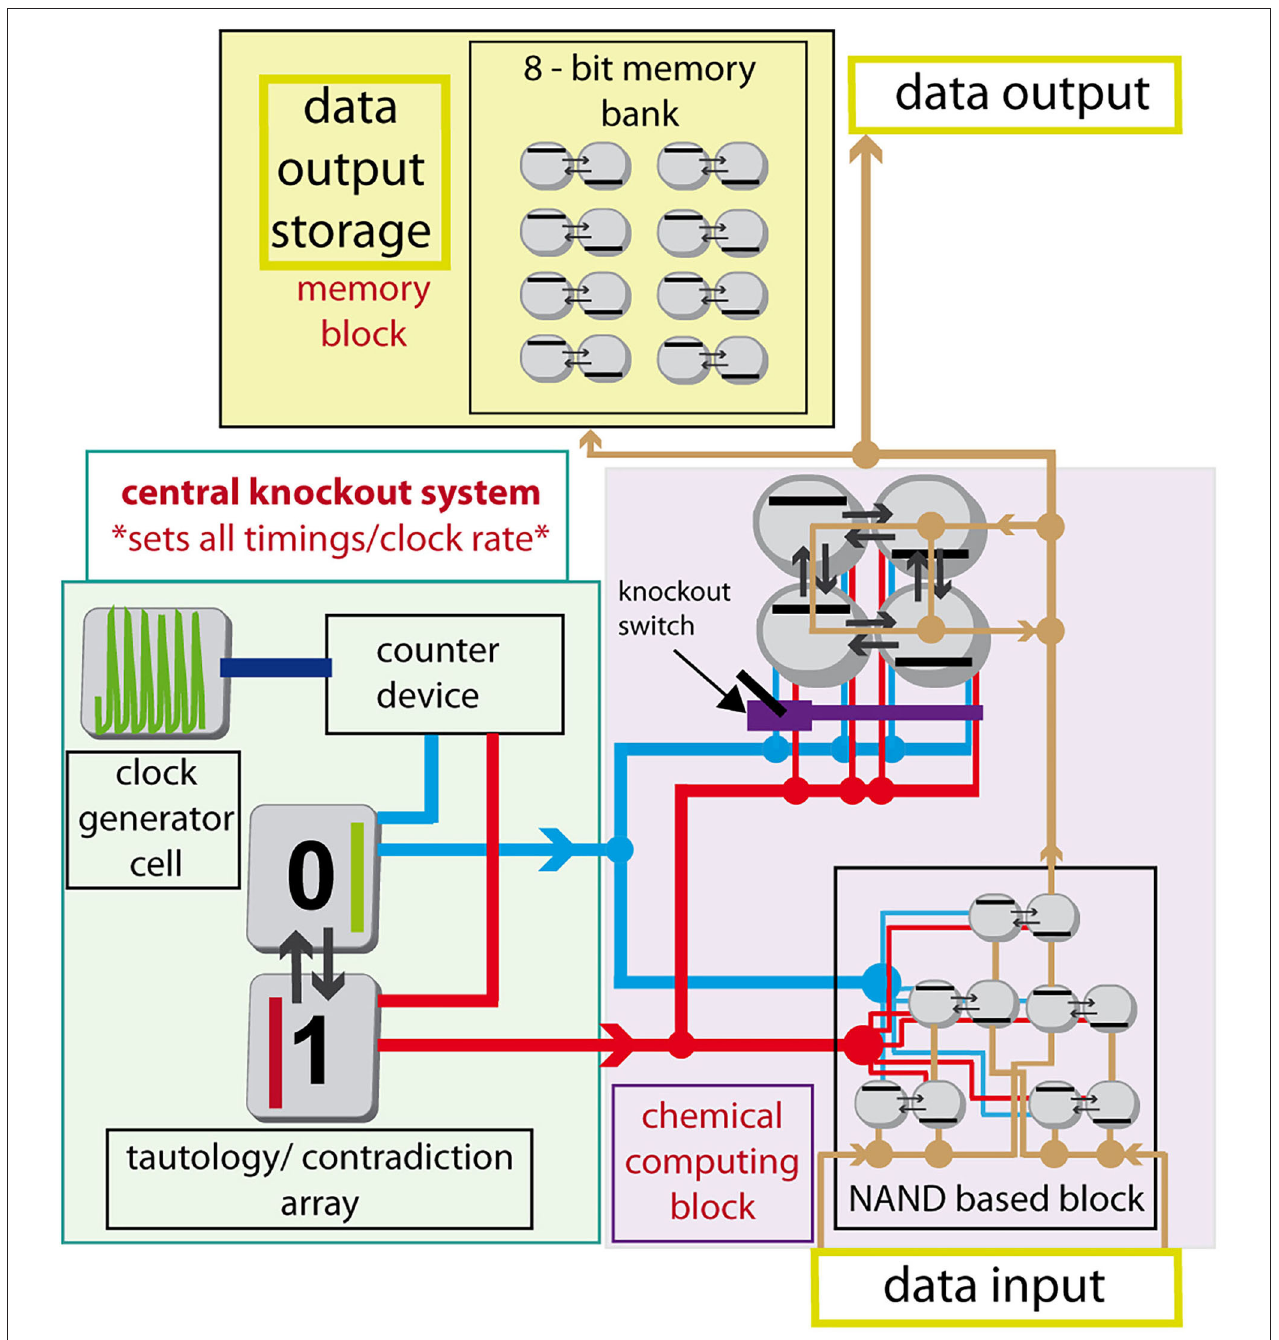
FIGURE 8 | Schematic diagram of an advanced cellular assemblage with chemical computing block, memory block, and central knockout system. Red line—knockout channel with signal 1, blue line—knockout channel with signal 0, brown line—data channel conducting signals 1/0, violet structure -knockout switch, counter device –counts 20 times the period 50.3s, then sends the pulse into tautology/contradiction device. Full circle on data or knockout channels represents a splitting